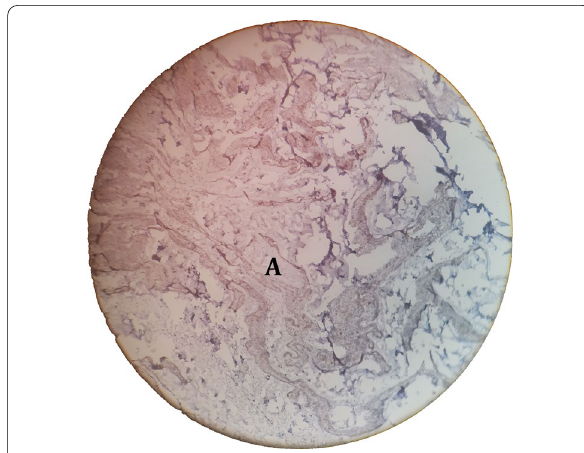
Fig. 15 IHC 40 image; showing EMA positivity in epithelial cell × lining of cyst wall as ‘A’